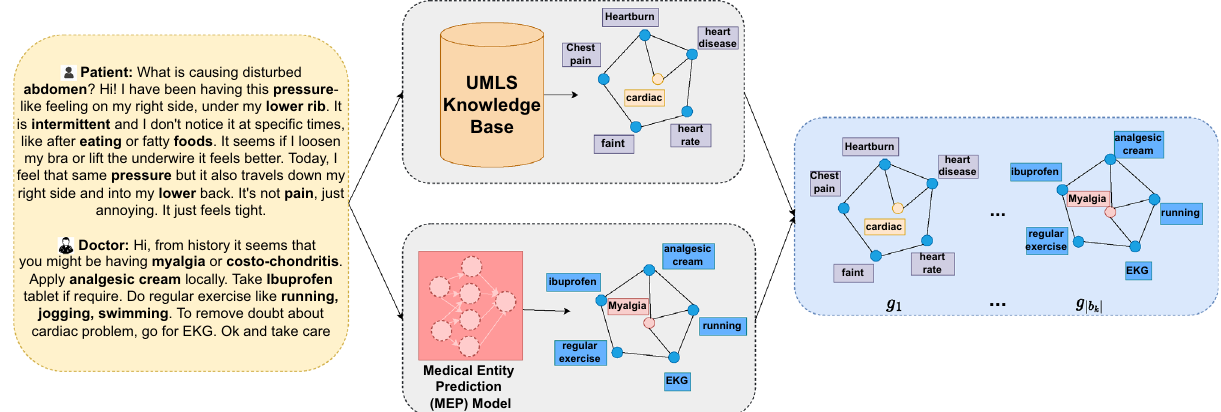
Figure 1. Medical Knowledge Graph: The patient-doctor dialogue as shown on the left is first passed through the Quick-UMLS tool , which is used to extract the medical concepts and relations from the UMLS knowledge base as shown in the box on top-middle. The box on the bottom-middle uses the MEP model to discover additional biomedical words present in the dialogues. Finally, the augmented knowledge graph used in the dialogue generation pipeline is shown in the